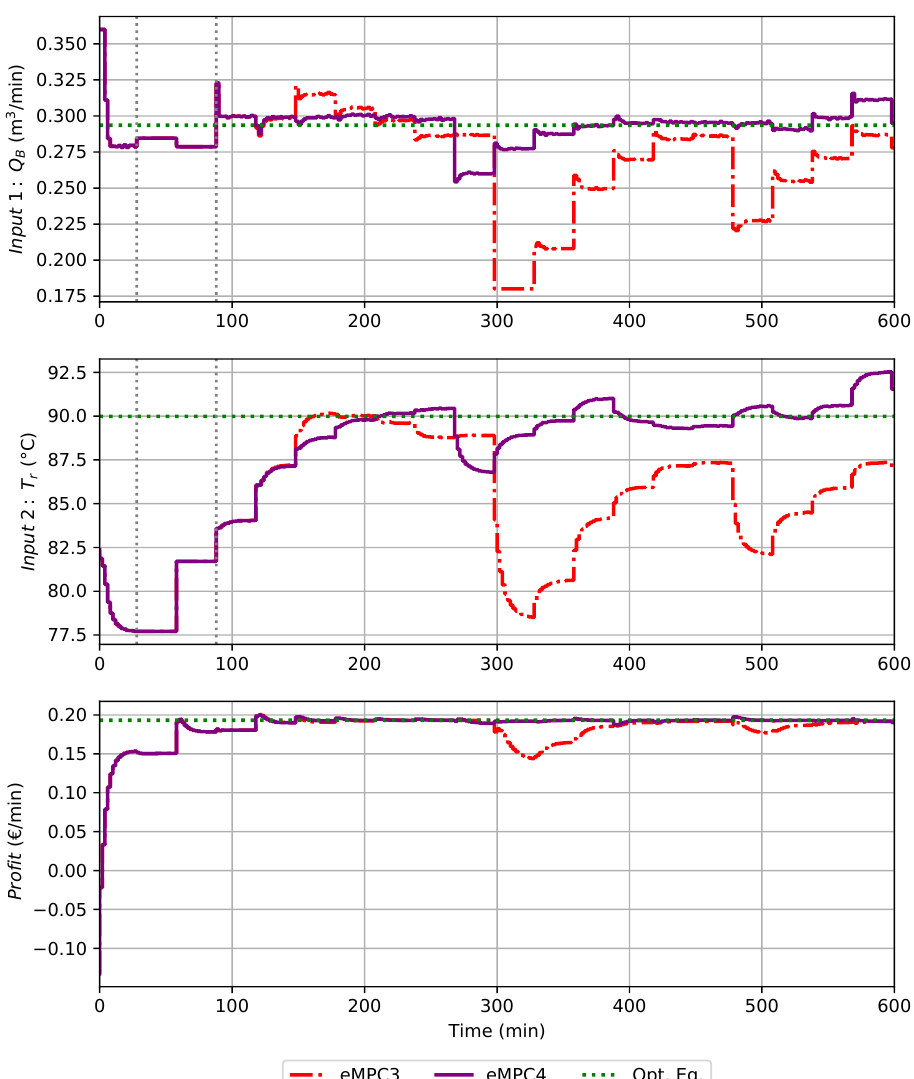
Figure 6. Performance of the Williams–Otto reactor with eMPC3 and eMPC4 in the presence of measurement noise: inputs ( top and middle ) and profit ( bottom ). The dotted vertical lines depict the time interval of 30–90 min used for Λ